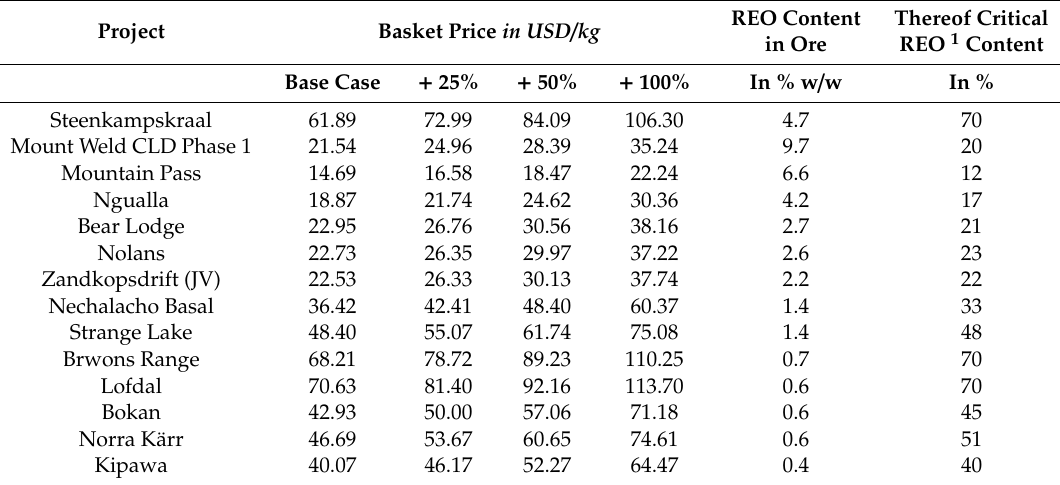
Table 2. Overview of basket prices of the 14 projects outside of China for di ff erent scenarios and the content of REO [41–43] to calculate the